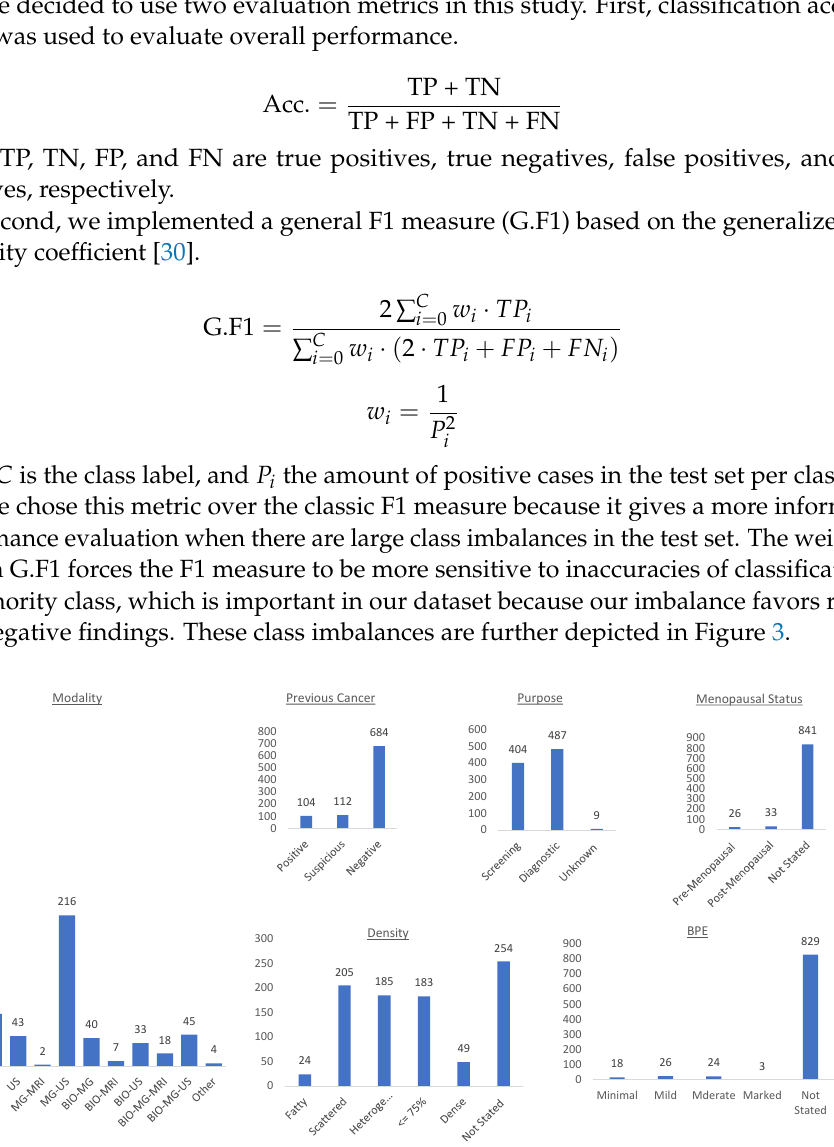
Figure 3. Histograms of the labels for each field that is extracted from the breast radiology reports fine-tuning dataset. We can see that each task suffers from a dominating label, which makes G.F1 better at quantifying performance over